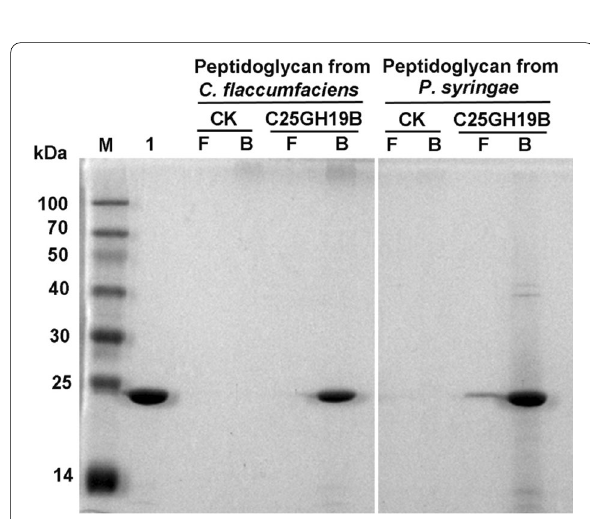
Fig. 7 SDS-PAGE analysis of the binding ability of C25GH19B on phytopathogenic bacterial peptidoglycan. Lane M, protein molecular weight marker; Lane 1, free C25GH19B protein; CK, peptidoglycan treated with the acetate buffer; C25GH19B, peptidoglycan treated with C25GH19B; F, free protein in the supernatant; B, peptidoglycan-bound